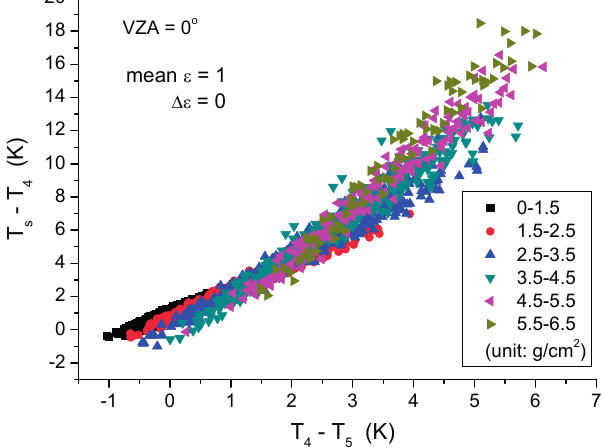
and (cid:1846) calculated for all of the (cid:3398) (cid:1846) (cid:3398) (cid:1846) (cid:3046) (cid:2872) (cid:2872) (cid:2873)